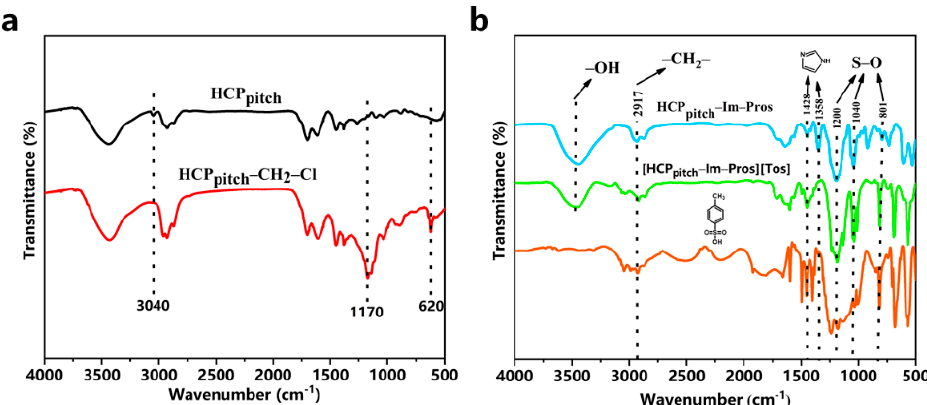
Figure 3. Fourier transform infrared (FTIR) spectra of samples: ( a ) HCP pitch and HCP pitch –CH 2 –Cl and